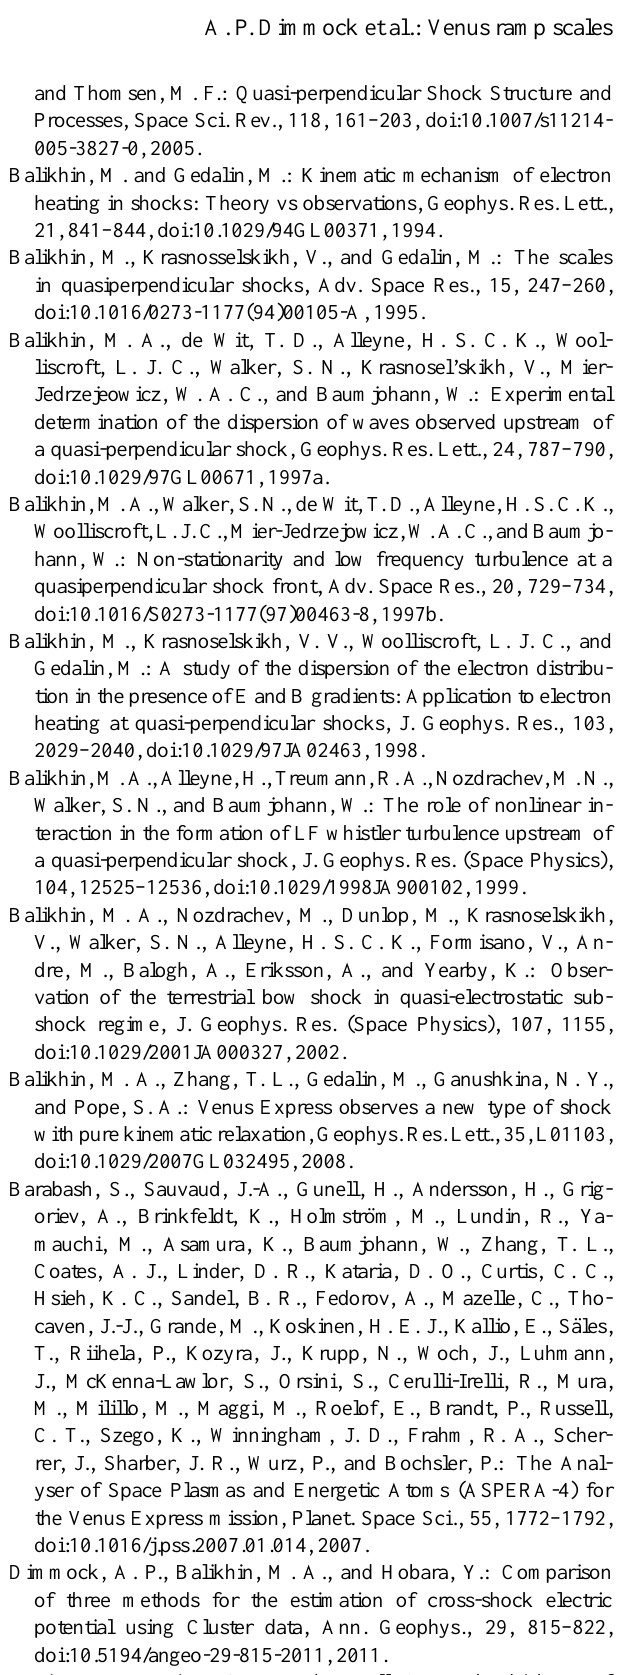
Fig. 5. Overshoot ( A = B o